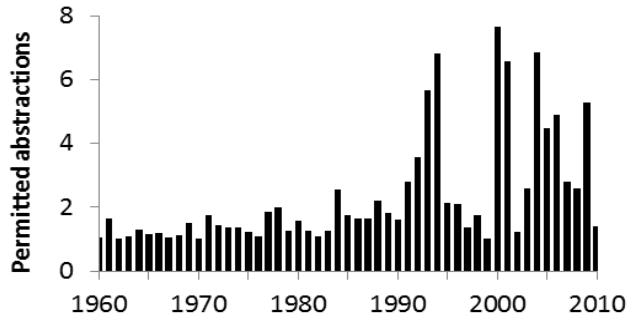
Figure 6. Permitted abstractions (m 3 s − 1 ) in the upper catchment of the Ewaso Ng’iro